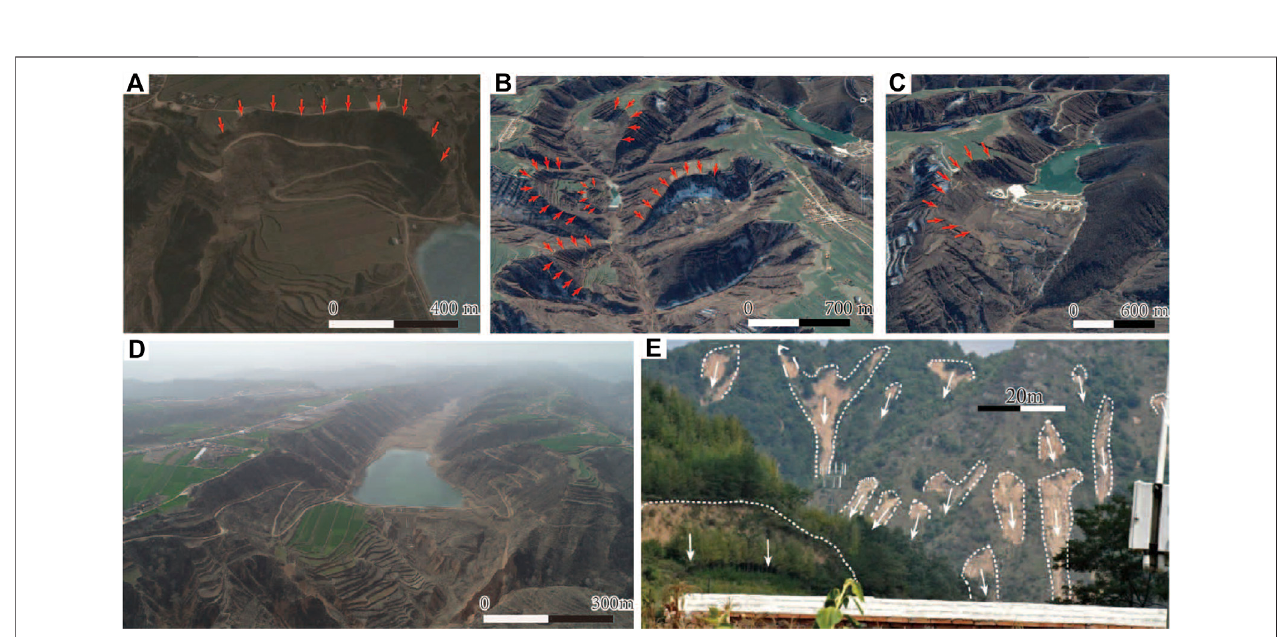
FIGURE 6 | Google images of typical historical landslides and barrier lakes (A – C) , UAV. photos of historical landslides(d), and photos of rainfall landslides (E) .